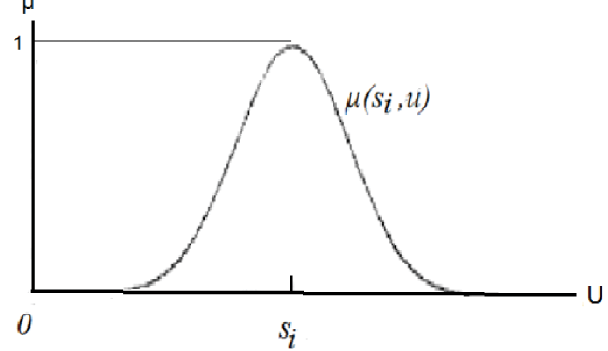
Fig. 4. Information diffusion function of s i on a continuous universe of discourse U